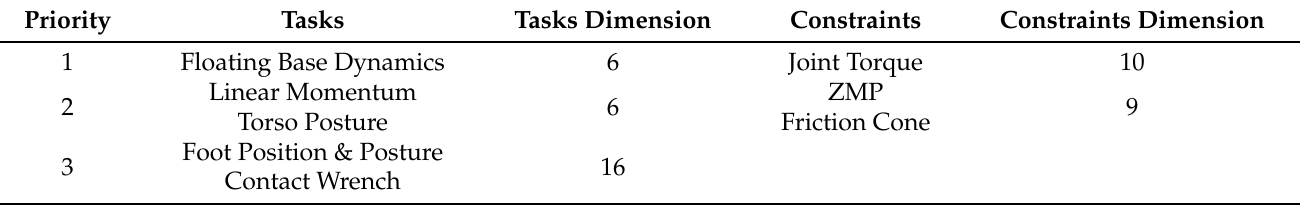
Table 1. Tasks, Constraints, and Priority Setting of Whole-Body Control for Single Leg Balance Standing. Priority Tasks Tasks Dimension Constraints Constraints